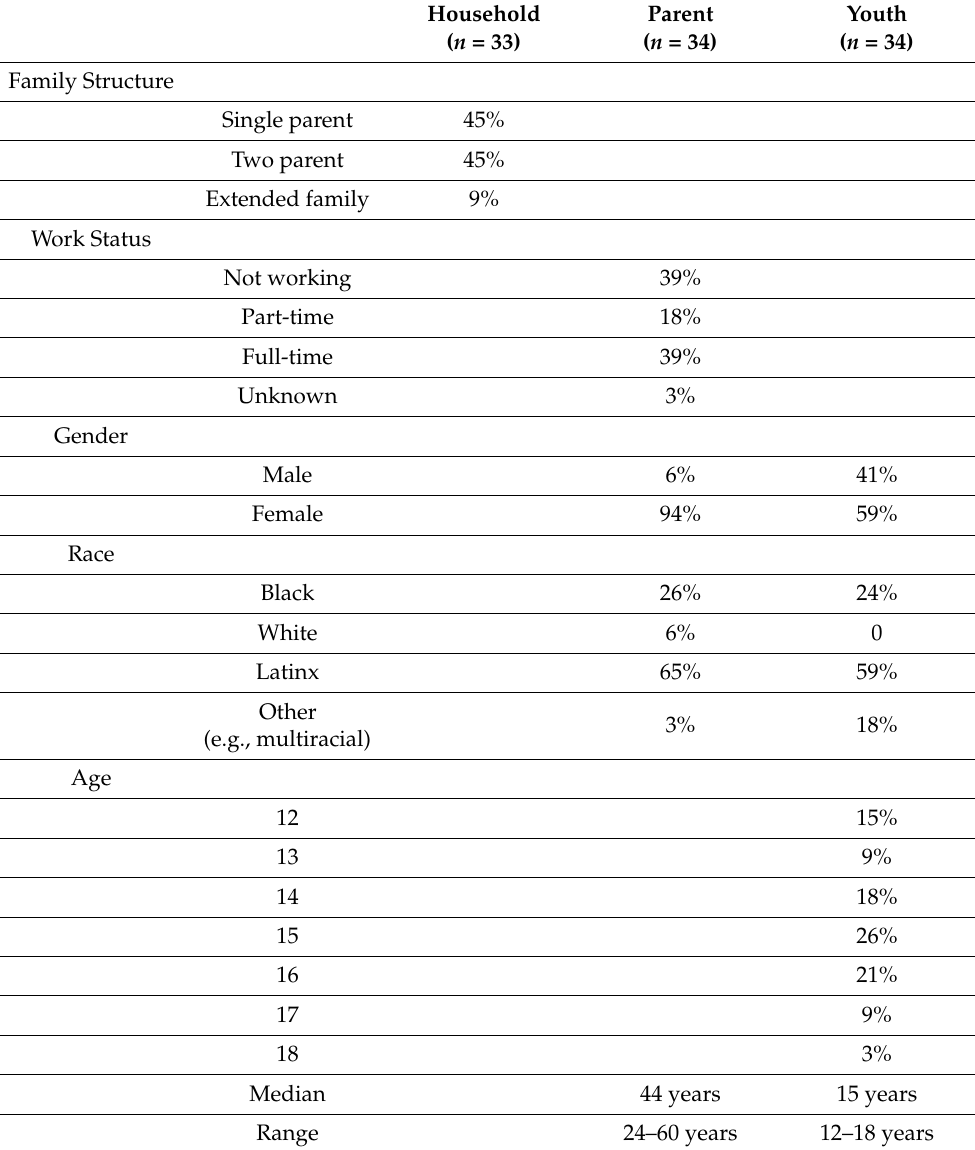
Figure 2. Phase 2 research design and data collection. Table 1. Population